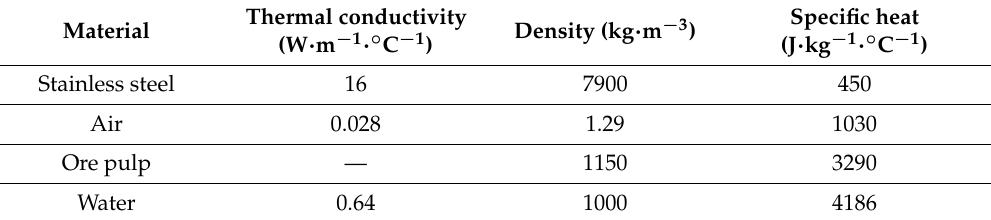
Table 4. Physical property parameters of the materials.